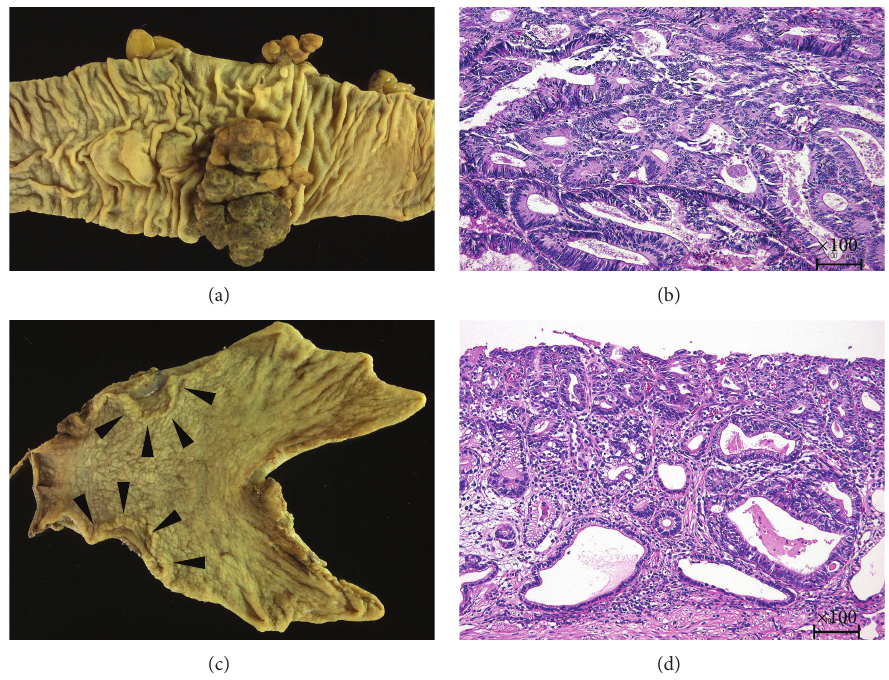
Figure 3: Macroscopic and microscopic findings of the sigmoid colon and gastric cancers. (a) The sigmoid colon contained a nearly circumferential polypoid tumor. (b) Histological examination revealed well-differentiated adenocarcinoma invading the subserosa (hematoxylin and eosin; original magnification, × 100). (c) The stomach contained a superficial depressed and elevated type tumor in the greater curvature of the lower third of the stomach (black arrowheads). (d) Histological examination revealed well- to moderately differentiated adenocarcinoma confined to the mucosa (hematoxylin and eosin; original magnification, × 100).